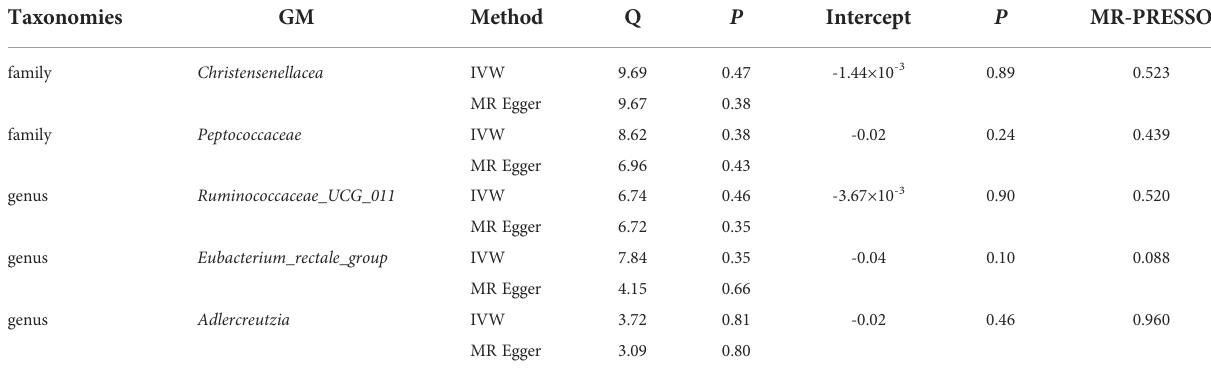
TABLE 3 Sensitivity analysis between GM and DR.